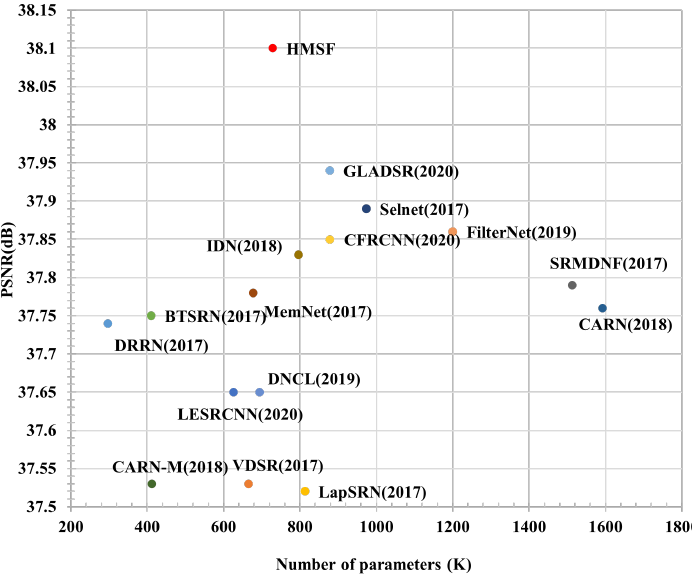
Figure 8. PSNR of recent CNN models for scale of 2 × on Set5 [49]. The redpoint result is from our HMSF. Our model achieves the best performance, although the number of network parameters is relatively small.